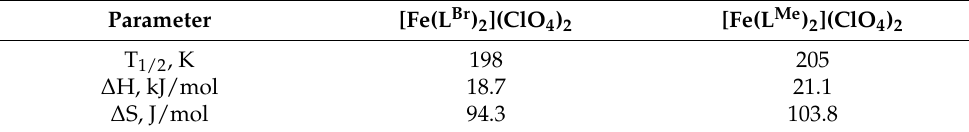
Figure 4. HS state population of [Fe( L Br ) 2 ](ClO 4 ) 2 and [Fe( L Me ) 2 ](ClO 4 ) 2 in acetonitrile-d 3 from the analysis of the temperature dependence of chemical shifts in variable-temperature NMR spectra. The lines correspond to the best fit by a regular solution model [53]. For the HS state population from the Evans method, see Figure S6 of ESI. Table 2. SCO parameters 1 from the NMR data for [Fe( L Br ) 2 ](ClO 4 ) 2 and [Fe( L Me ) 2 ](ClO 4 ) 2 in acetonitrile-d 3